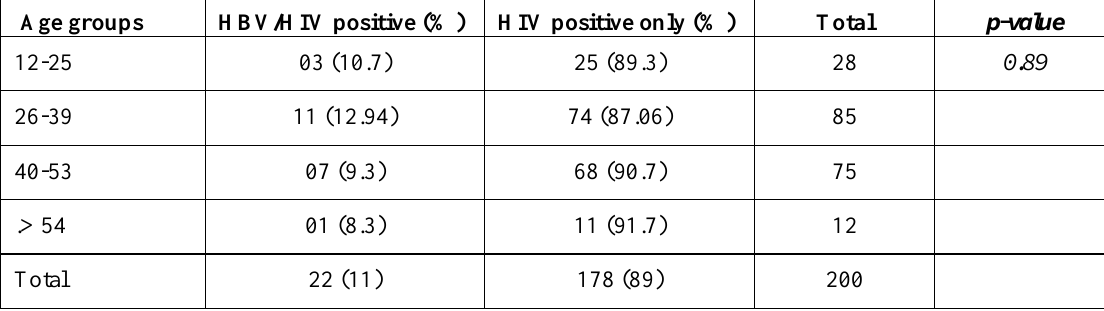
Table 2. Distribution of HBV co-infection in relation to